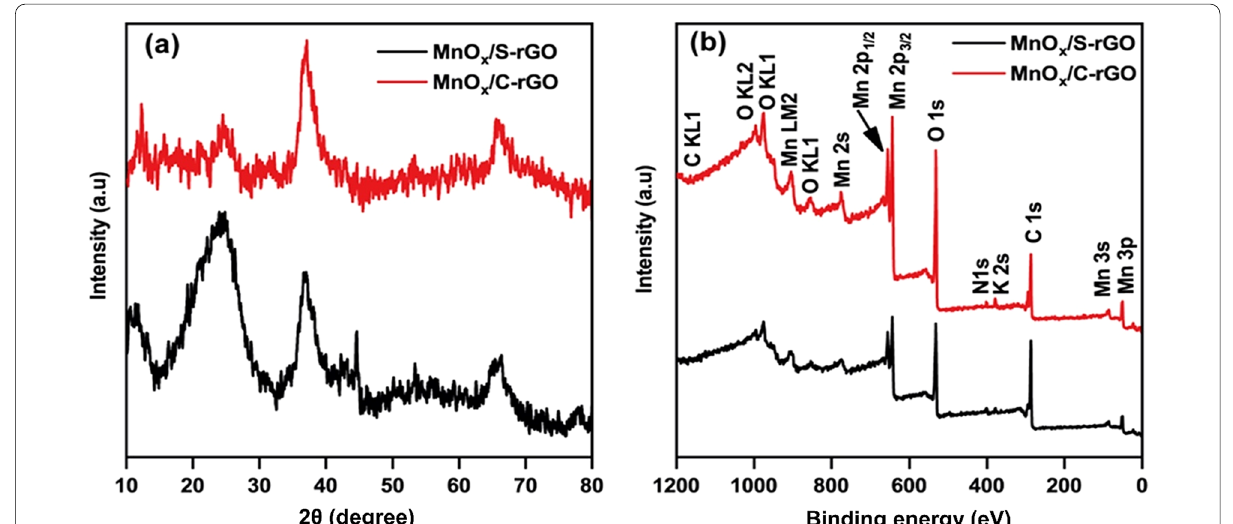
Fig. 2 a XRD patterns and b XPS survey spectra of MnO x /S-rGO and MnO x